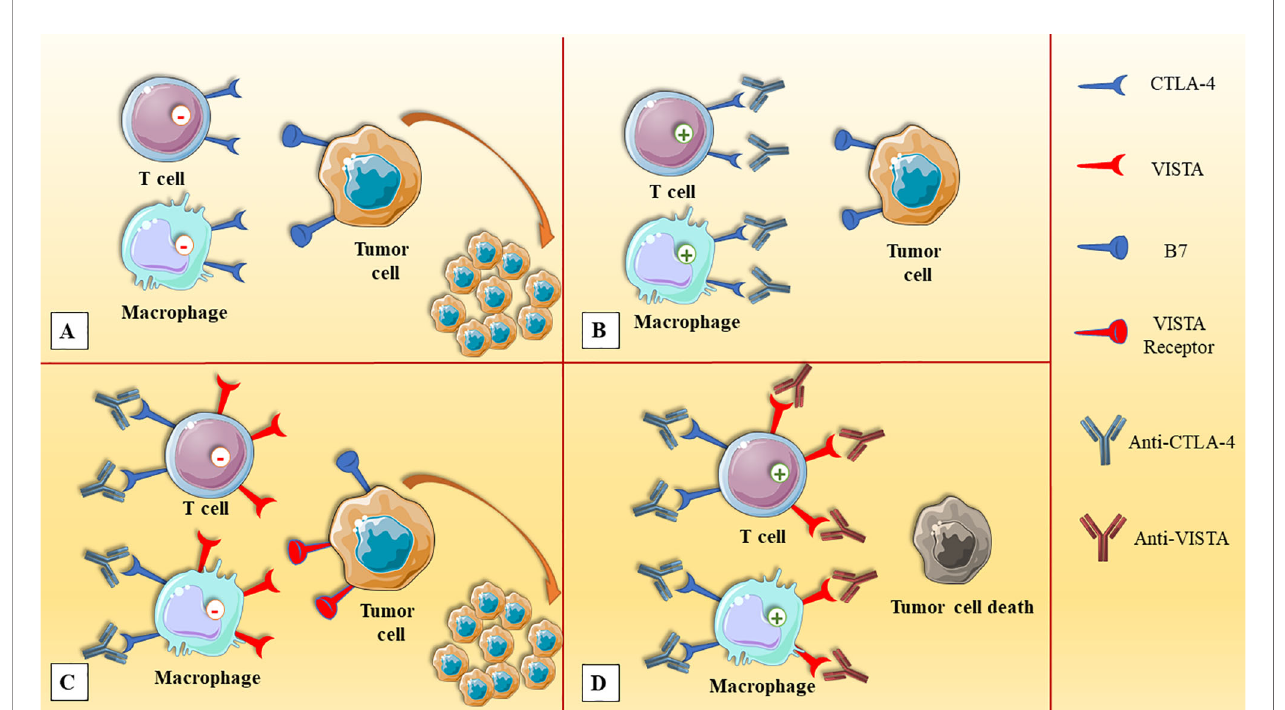
FIGURE 2 | The upregulation of VISTA in prostate cancer after anti-CTLA-4 therapy. (A) The expression of CTLA-4 on immune cells, e.g., T cells and macrophages, and its interaction with tumoral cells can attenuate anti-tumoral immune responses. (B) The administration of anti-CTLA-4 can stimulate anti-tumoral immune responses. (C) After anti-CTLA-4 therapy, the upregulation of VISTA inhibits immune cell activation and leads to tumor expansion. (D) Dual VISTA/CTLA-4 blockade can elicit synergistic responses and leads to the elimination of prostate cancer cells. CTLA-4, cytotoxic T-lymphocyte-associated protein-4; VISTA, V-domain Ig suppressor of T cell